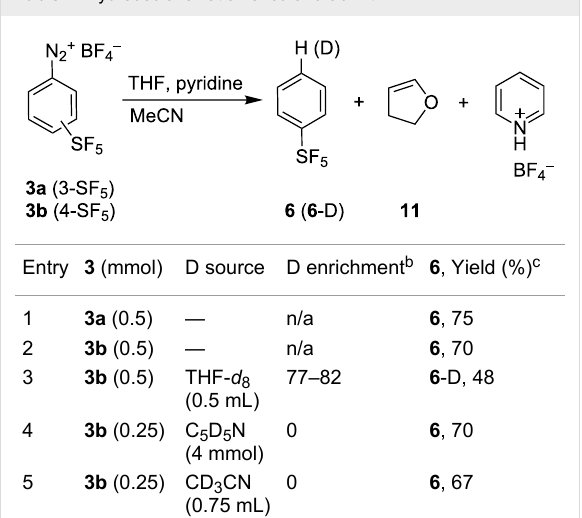
Table 4: Hydrodediazoniation of 3a and 3b with THF a